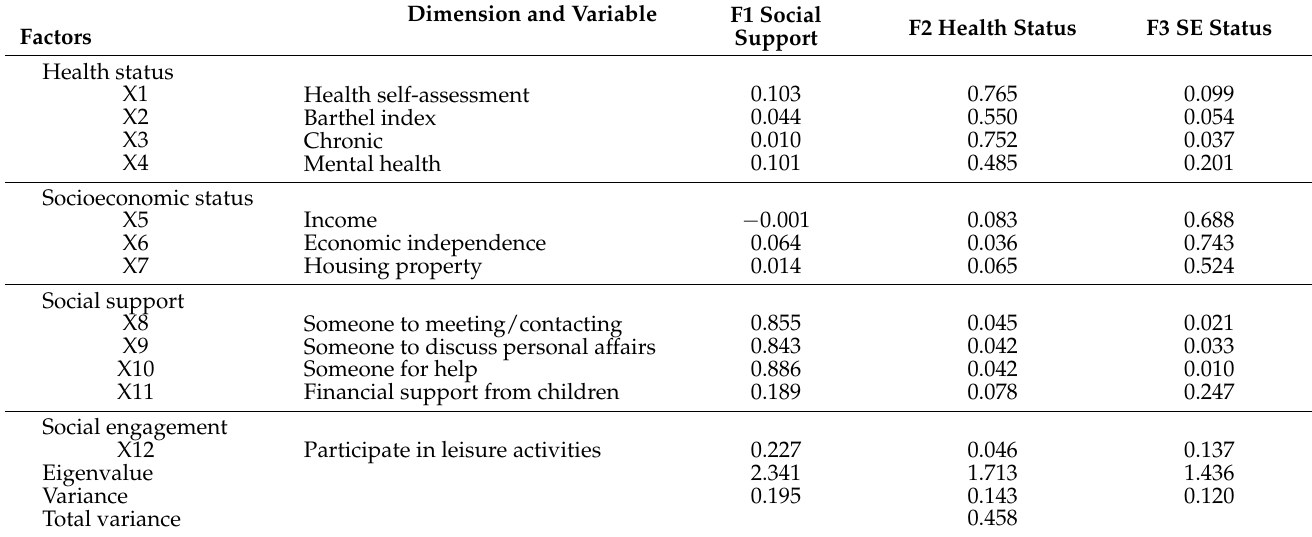
Table 3. Factor load matrix.